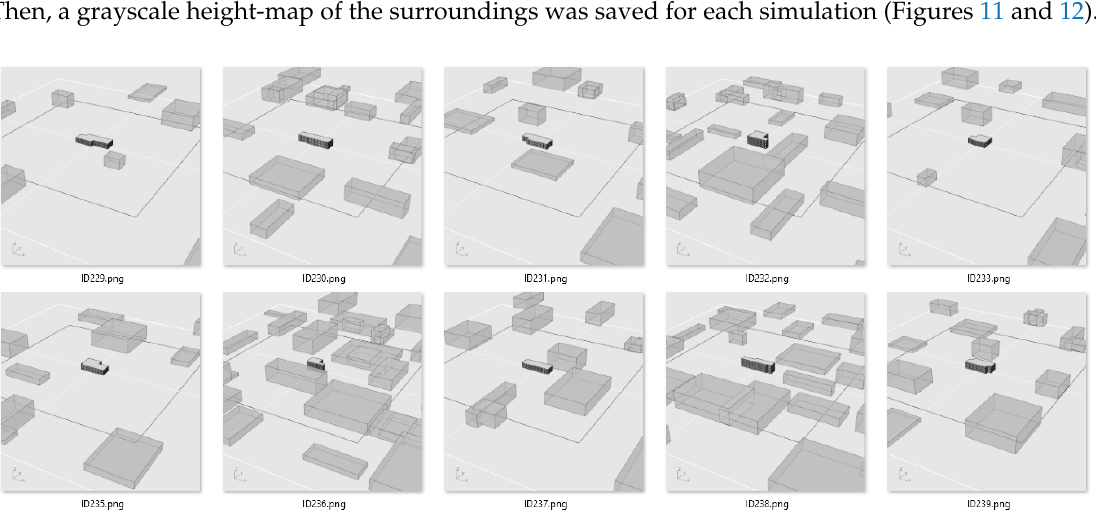
Figure 10. Randomized urban layouts for Convolutional Neural Network (CNN) training. A 3D view representing the model.